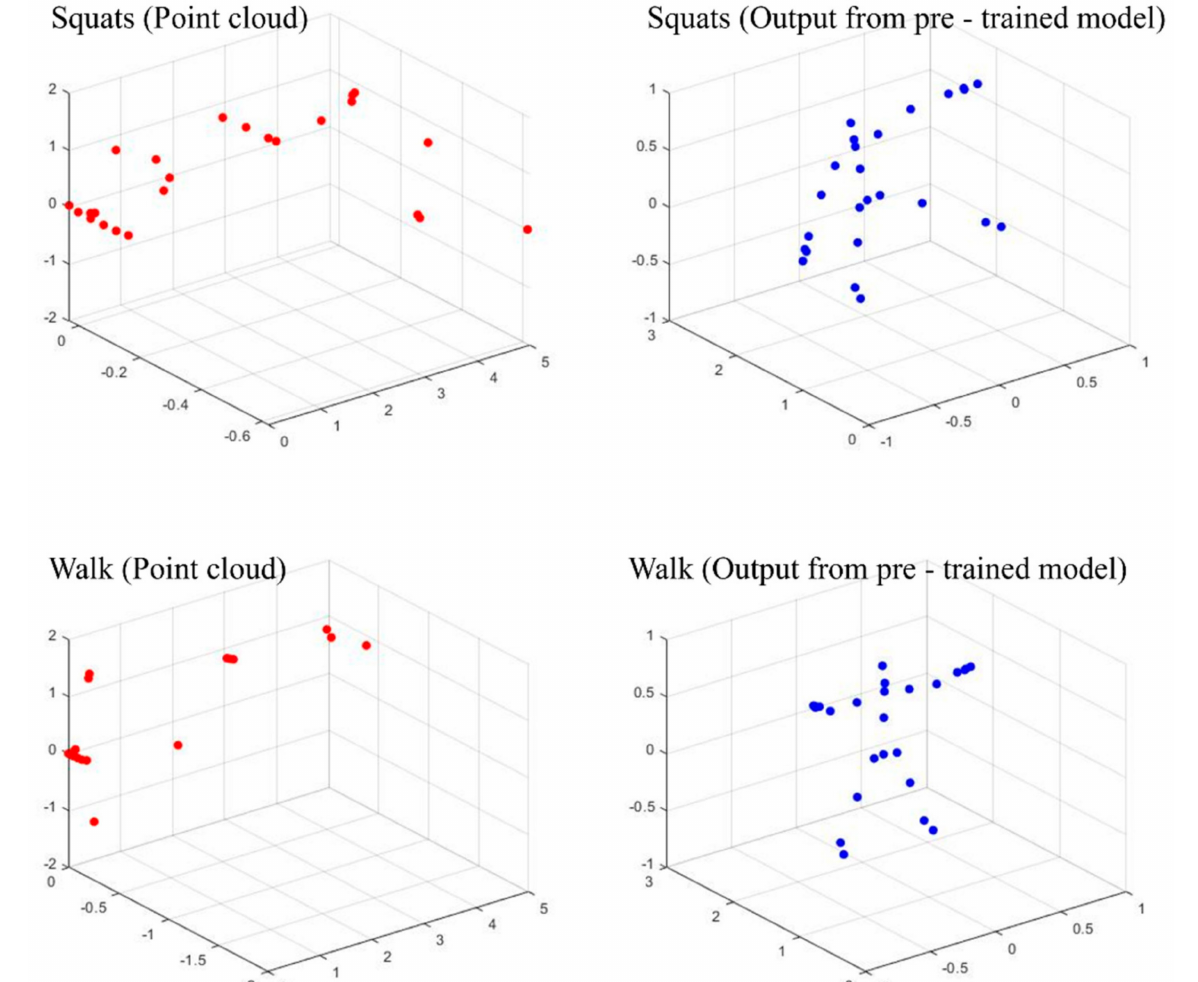
Figure 5. Human joints created from point cloud data. On the ( left ) is raw point cloud data, and on the ( right ) is output from the pre-trained